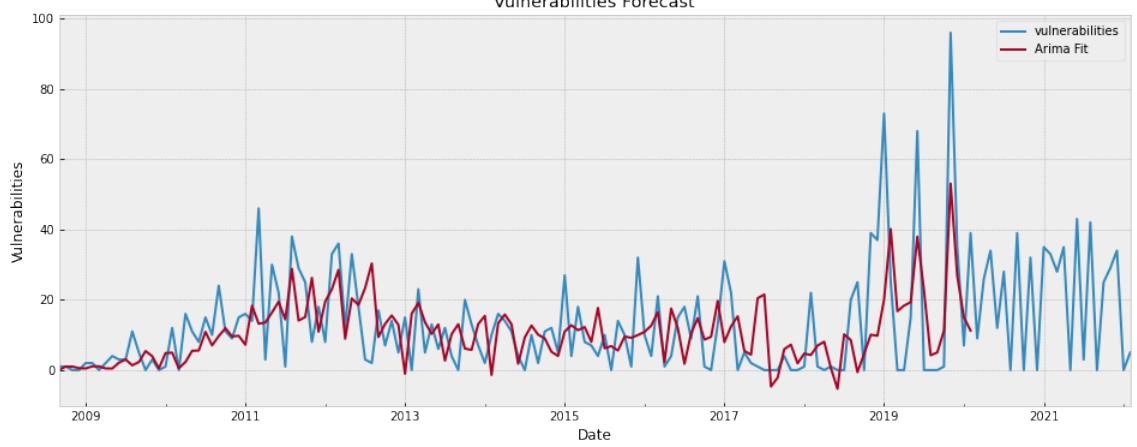
Figure 3. Google Chrome vulnerability fit using